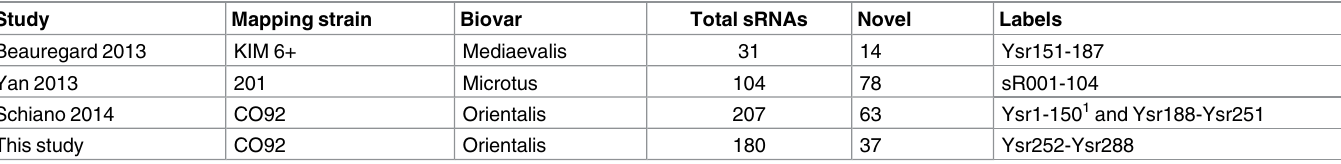
Table 3. Yersinia pestis small RNA